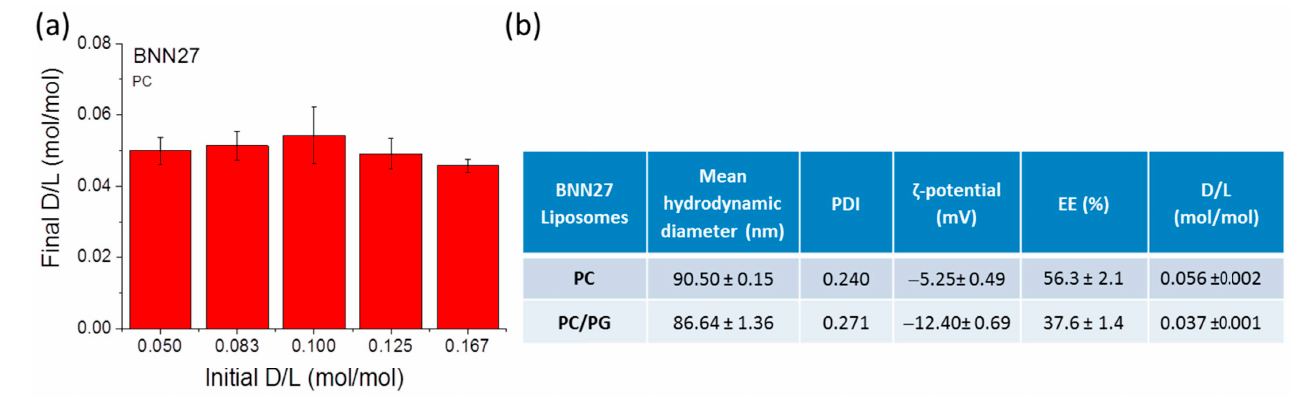
Figure 1. ( a ) Effect of increasing the initial amount of BNN27 (or D/L mol/mol ratio) on the amount of BNN27 loaded in PC small unilamellar LIPs. ( b ) Physicochemical properties of BNN27-loaded LIPs. Each value is the mean from at least three independent